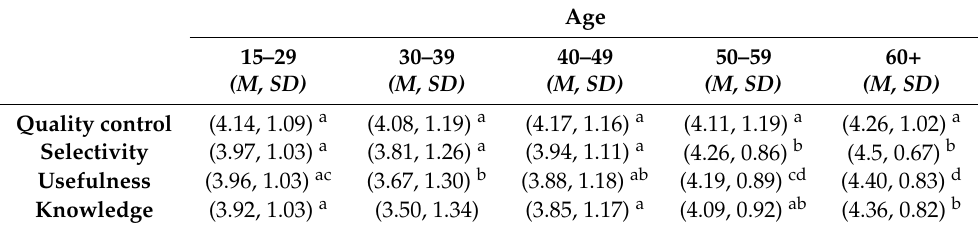
Table 1. Attitudes towards journalistic gatekeeper functions by age.